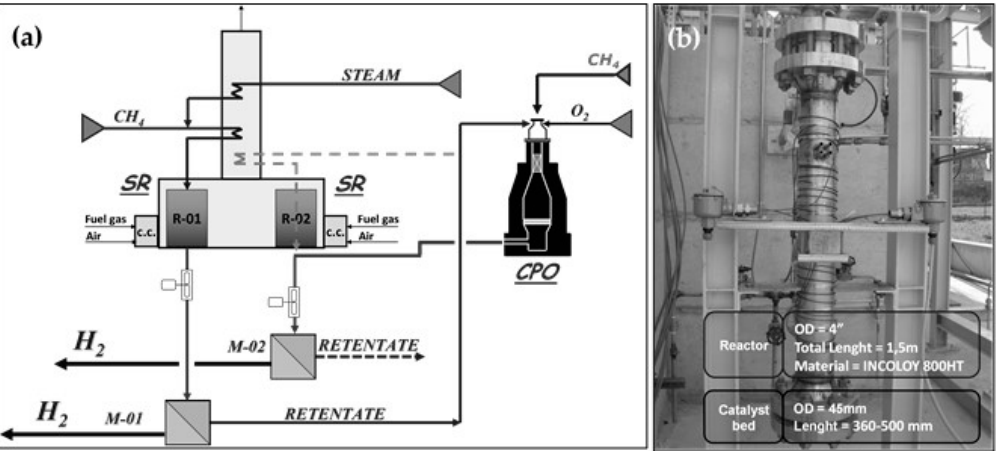
Figure 3. Syngas/pure hydrogen production membrane reactor for gas-to-liquid (GTL) process ( a ) Process scheme; ( b ) Catalytic partial oxidation (CPO) reactor assembly.